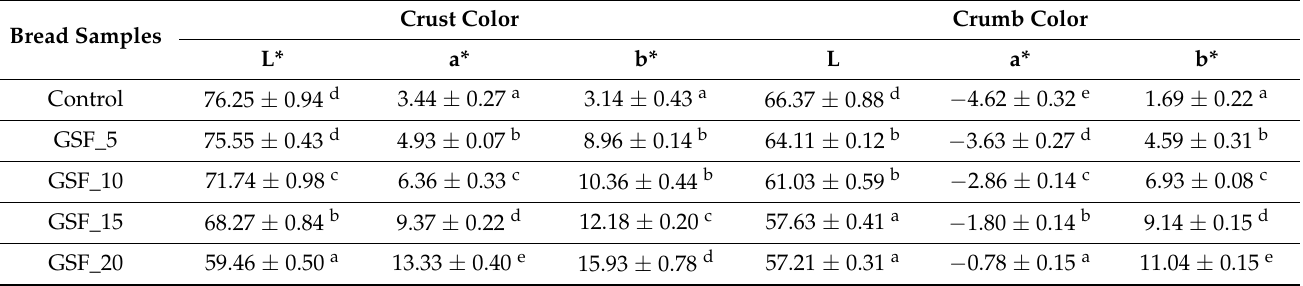
Table 4. Color parameters of the bread with different proportions of GSF supplementation in wheat